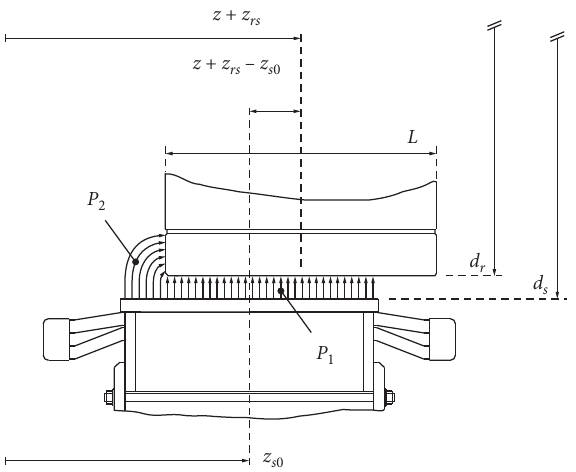
Figure 10: Axial magnetic force